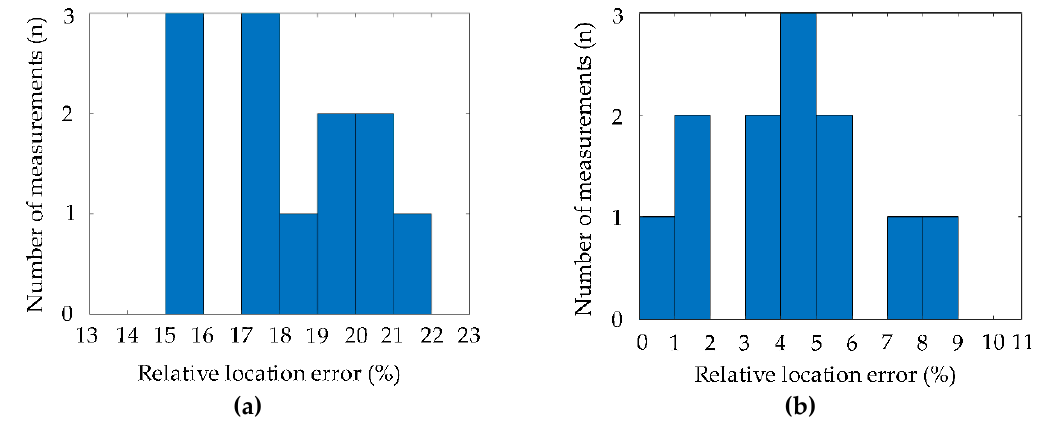
Figure 15. Histograms of the relative location errors obtained by two methods: ( a ) CCF location method and ( b ) MLPNN locator.